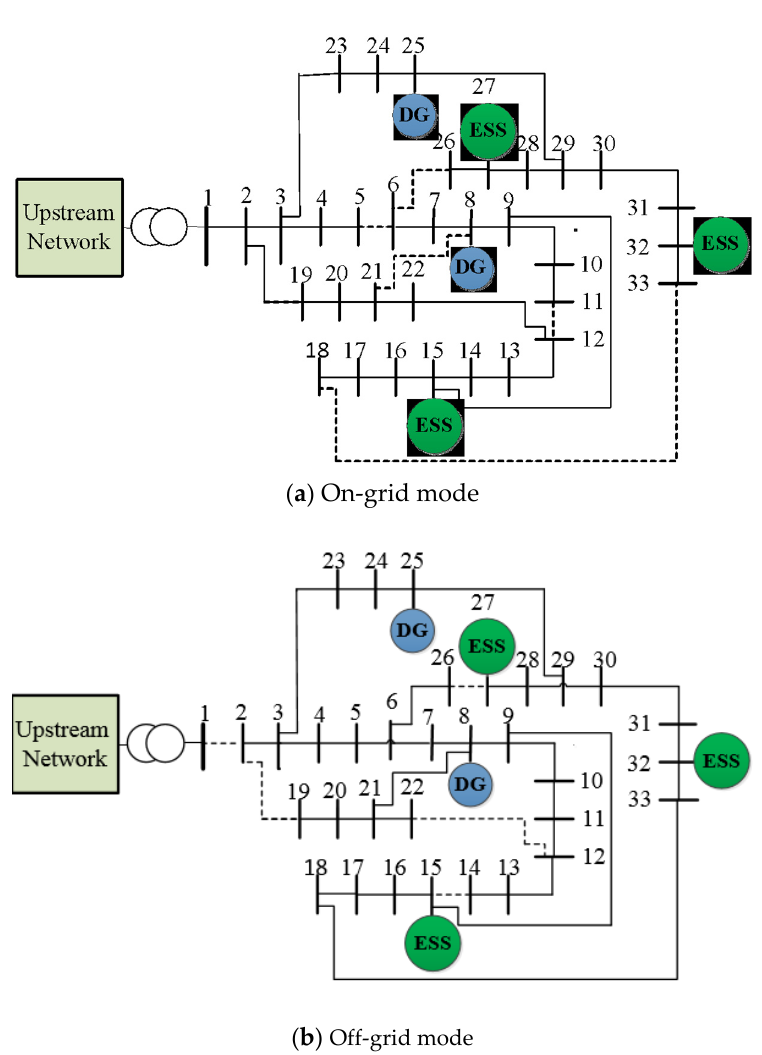
Figure 6. Optimal configuration of the network in RA: ( a ) on-grid operation mode; ( b ) off-grid operation mode.